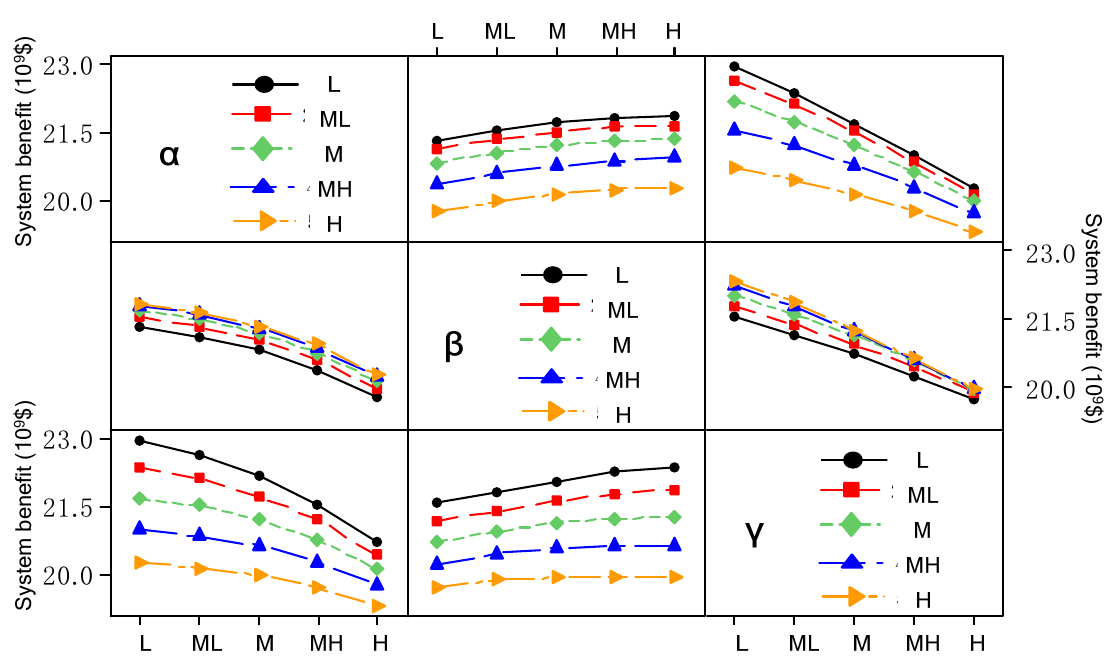
Figure 8. Interactive effects of multiple parameters on the system’s benefits.